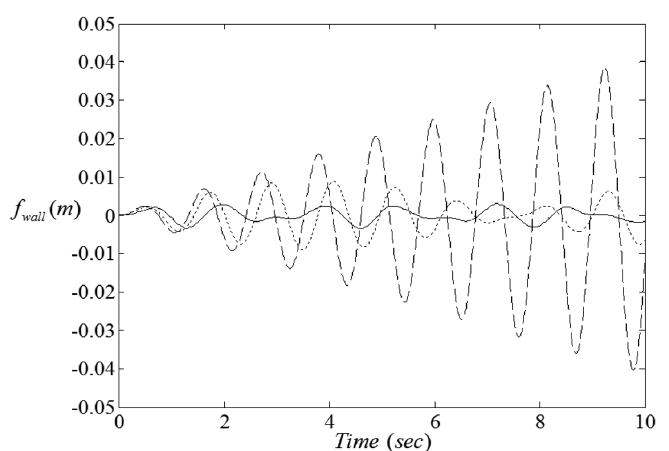
Fig. 5. Sloshing displacement at the container wall under the harmonic excitation for R 1 / R 2 = 0.6 and three different h 1 / R 2 ( h 1 / R 2 = 0.1, ······ h 1 / R 2 = 0.3, − − − h 1 / R 2 =